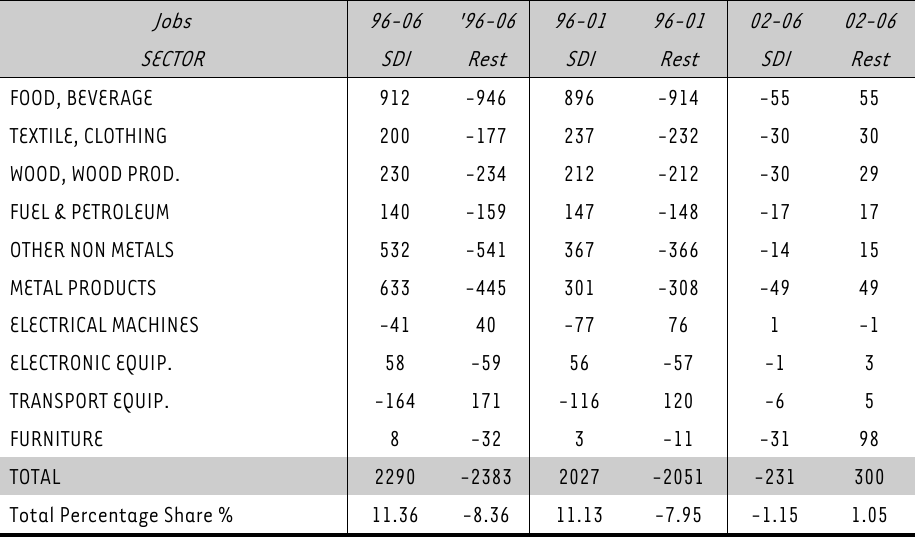
TABLE 5: Regional competitive share effect